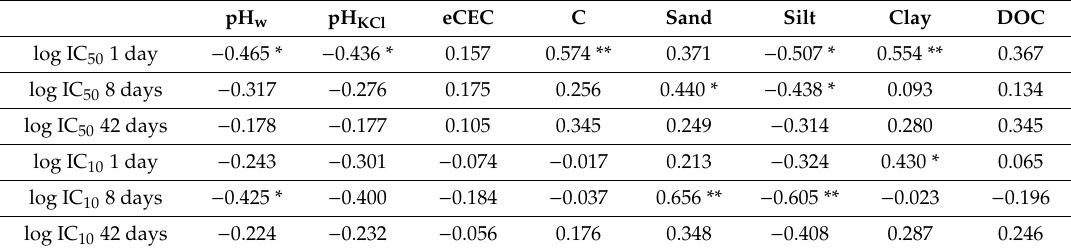
Table 3. Pearson correlation coe ffi cients between properties of the studied soils ( n = 22) and log IC 50 and log IC 10 estimated for oxytetracycline after 1, 8 and 42 incubation days. pH w